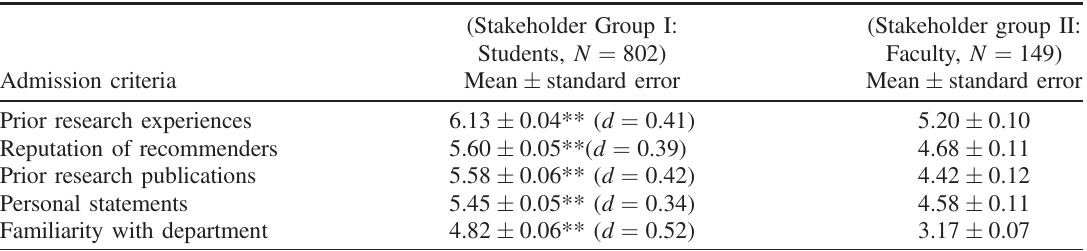
TABLE II. Mean response and standard errors of significantly different admission criteria. (Note that **: p < 0 . 001